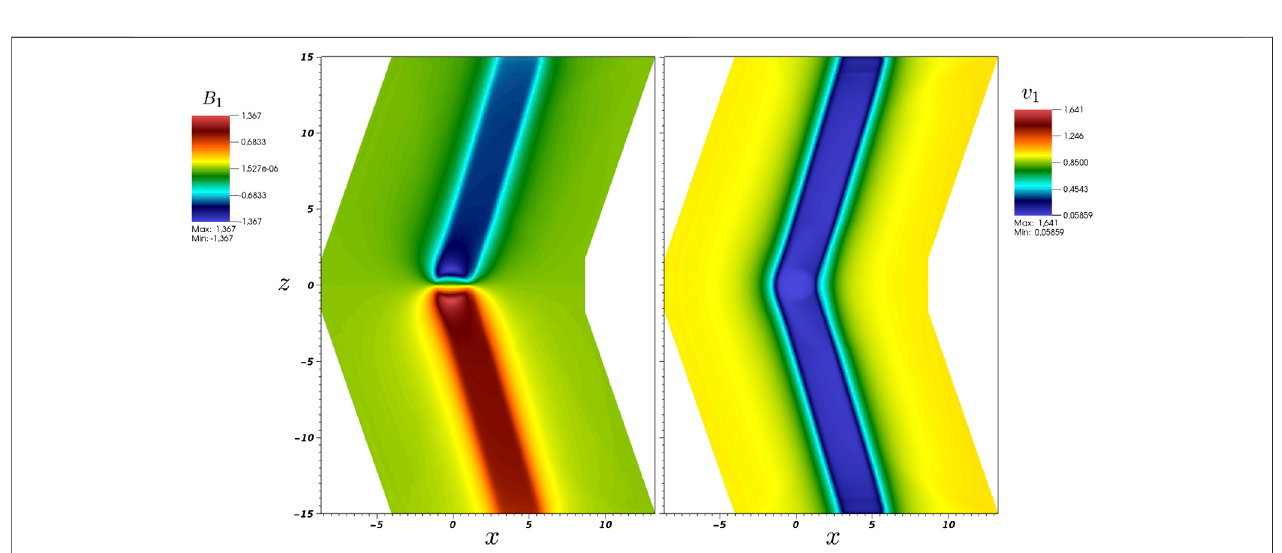
FIGURE5| Alfvénwingsnumericallycomputed withtheentropystable DGSEMfortheplasmainteraction ofaspherical gascloud. Thesnapshot isasliceinthe xz plane at y (cid:3) 0 at the fi nal time T (cid:3) 5. The polynomial order in each spatial direction was N (cid:3) 3 in each spatial direction. As expected, the Alfvén wings evolve from the northern and southern poles of the neutral gas cloud and are bent back by a constant angle with respect to the background magnetic fi eld. This bending was taken into account in the construction of the curvilinear mesh.